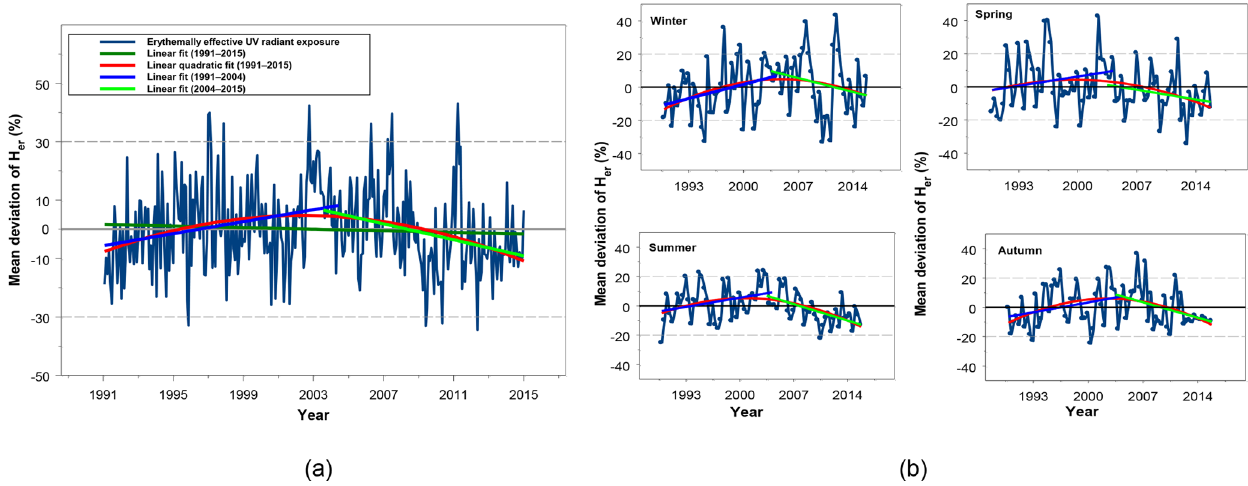
Figure 2. Monthly mean deviation of H er data at Chilton (1991–2015) with trend lines: ( a ) all seasons combined and ( b ) seasonal.